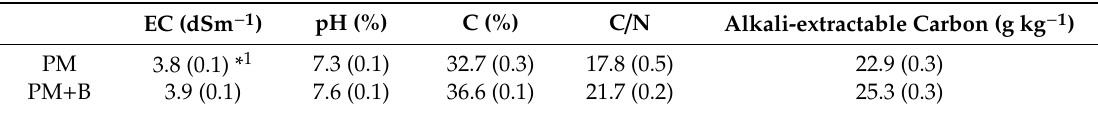
Table 1. Selected chemical-physical properties of poultry manure (PM) and poultry manure blended compost with biochar (PM +